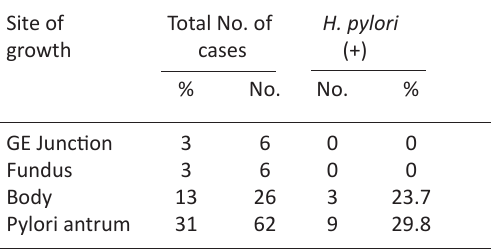
Table 3. Site of growth and incidence of H. pylori to site of Growth